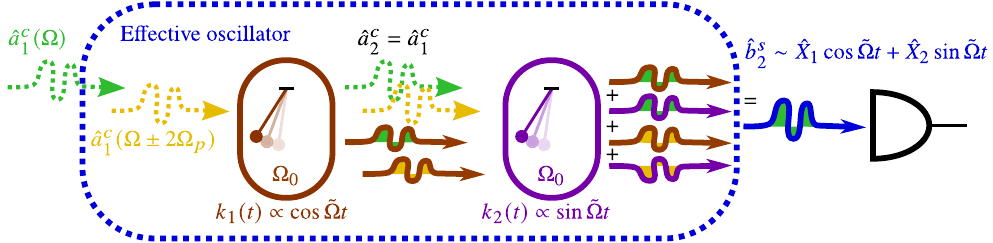
FIG. 5. Scheme for removing the extraneous QBA contribution (36) (thick arrows with yellow filling) induced by the spectral using coherent cancelation. A single, effective oscillator with the desired sideband components ∼ ± 2 ˜ (cid:2) (yellow dashed arrow) of ˆ a c 1 behavior is formed from cascading two identical oscillators that are two-tone driven out of phase: the extraneous QBA responses (thick arrows with yellow filling) cancel, while the nominal QBA responses (thick arrows with green filling) interfere